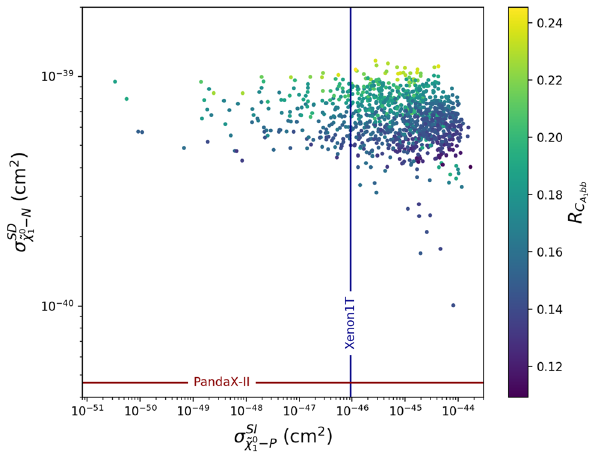
versus σ SD with (cid:2) χ 0 (cid:2) χ 0 − P − N 1 1 ≡ C / y b . Dark blue A 1 b ¯ b A 1 b ¯ b = 4 . 6 × (cid:2) χ 0 − N 1